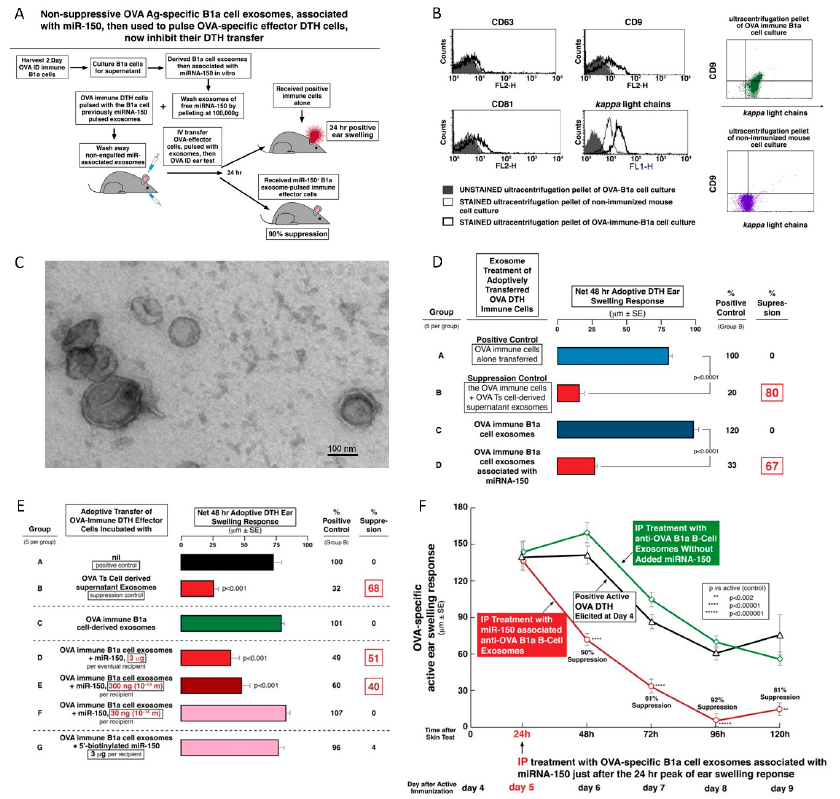
Figure 5. Non-suppressive OVA Ag-specific B1a cell exosomes inhibit adoptively transferred OVA DTH when associated with miRNA-150. ( A ) Experimental protocol. ( B ) OVA-specific B1a cell-derived exosomes were cytometrically analyzed for expression of CD9, CD63, and CD81 as general markers of small exosomes, after coupling onto beads (left and center). Furthermore, they were analyzed and found positive for co-expression of CD9 and antibody kappa free light chains (FLC, center, and upper right), while some in the pellet from ultracentrifuged culture supernatant from normal lymphoid cells expressed Ab FLC, but did not co-express CD9 (right lower). ( C ) B1a cell-derived exosomes were analyzed with transmission electron microscope, showing the presence of bilamellar vesicles. ( D ) Non-suppressive OVA Ag-specific B1a cell-derived exosomes become suppressive of OVA DTH adoptive transfer when in vitro associated with miRNA-150 (Group C vs. D). ( E ) A dose response experiment shows that non-suppressive OVA Ag-specific B1a cell-derived exosomes are rendered suppressive of DTH effector cell adoptive transfer by their association in vitro with low doses of miRNA-150. ( F ) OVA Ag-specific B1a cell-derived exosomes associated in vitro with inhibitory miRNA-150 are able to suppress active OVA DTH when injected intraperitoneally (IP) at the 24-h peak of ear swelling response, in contrast to similar exosomes not associated with miRNA-150 (red line vs. green line, 50–92% suppression over the subsequent four days), and compared to no treatment of this active DTH (the thick black line). Results of in vivo assays are shown as delta ± standard error (SE), one-way ANOVA with post hoc RIR Tukey test. n = 5 mice in each group or three samples.